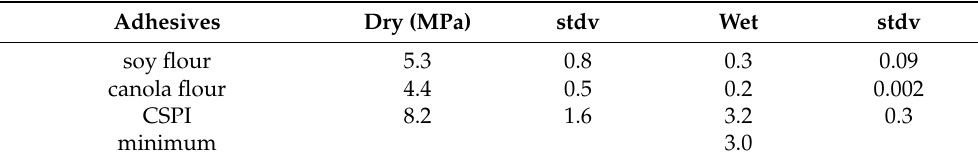
Table 1. ABES shear strength (MPa) of canola and soy flour adhesives tested dry (ambient conditions) and wet (water soaked) compared to CSPI and our preferred minimum value for further testing.